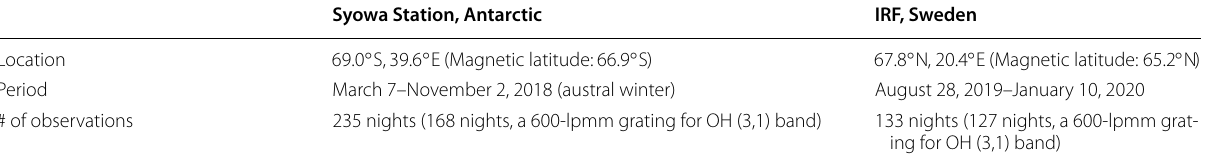
Table 1 A summary of locations and period for NIRAS